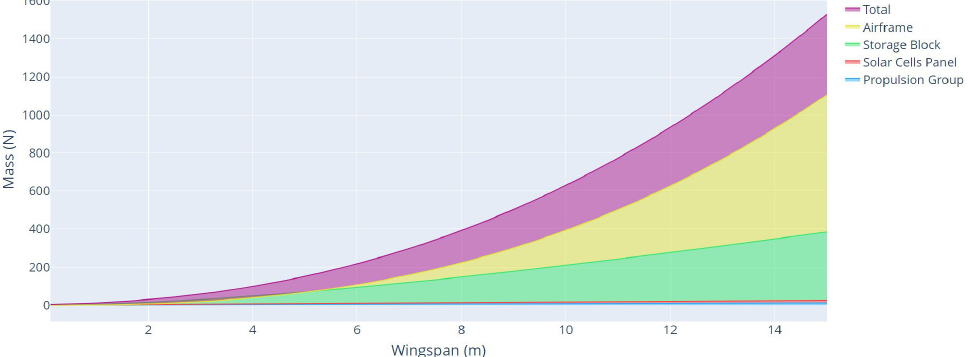
Figure 14. Aircraft mass as a function of wingspan with climbing power.